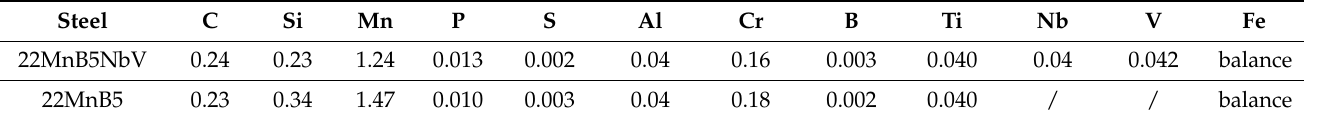
Table 1. Composition of 22MnB5NbV and 22MnB5 (wt.%).